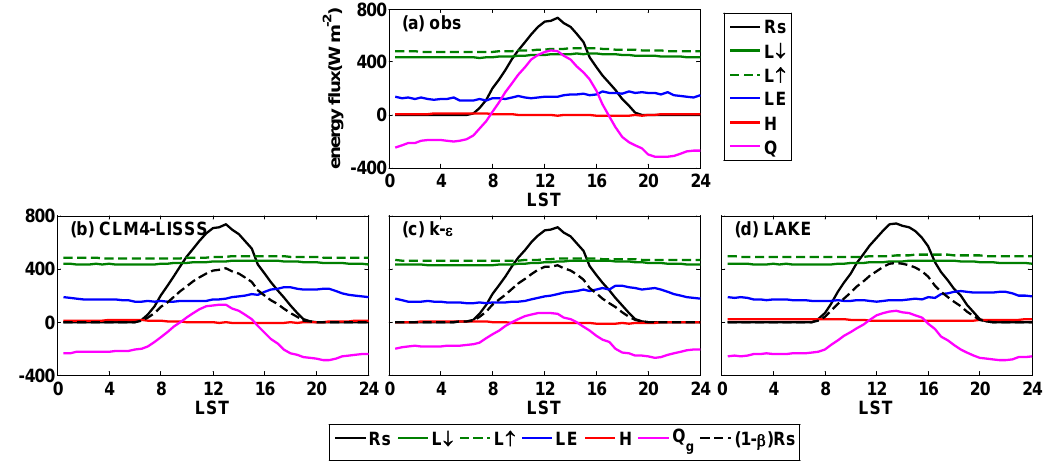
Figure 9. Simulation and observation of average monthly variation of lake surface layer energy in Taihu in August 2012. Rs is net radiation flux, L ↓ is downward long-wave radiation, L ↑ is upward long-wave radiation, and LE is latent heat Flux, H is the sensible heat flux, Qg refers to the heat transfer from the surface layer to the lake, and (1 − β ) Rs refers to the heat storage in the surface layer of the